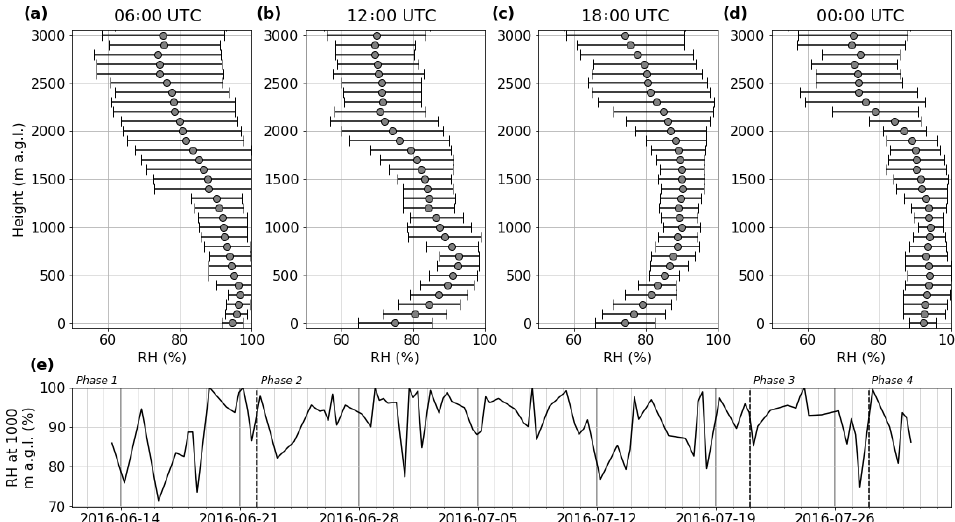
Figure 4. The mean and standard deviation of relative humidity measurements with altitude at (a) 06:00UTC ( n = 46), (b) 12:00UTC ( n = 15), (c) 18:00UTC ( n = 20) and (d) 00:00UTC ( n = 15), from radiosondes launched from the Savè ground site. Altitudes are above ground level (a.g.l.) (e) A time series of the RH at 1000m. Dashed vertical lines indicate the four different monsoon phases, as defined by Knippertz et al. (2017). (NB: local time in Benin is UTC + 1h.)